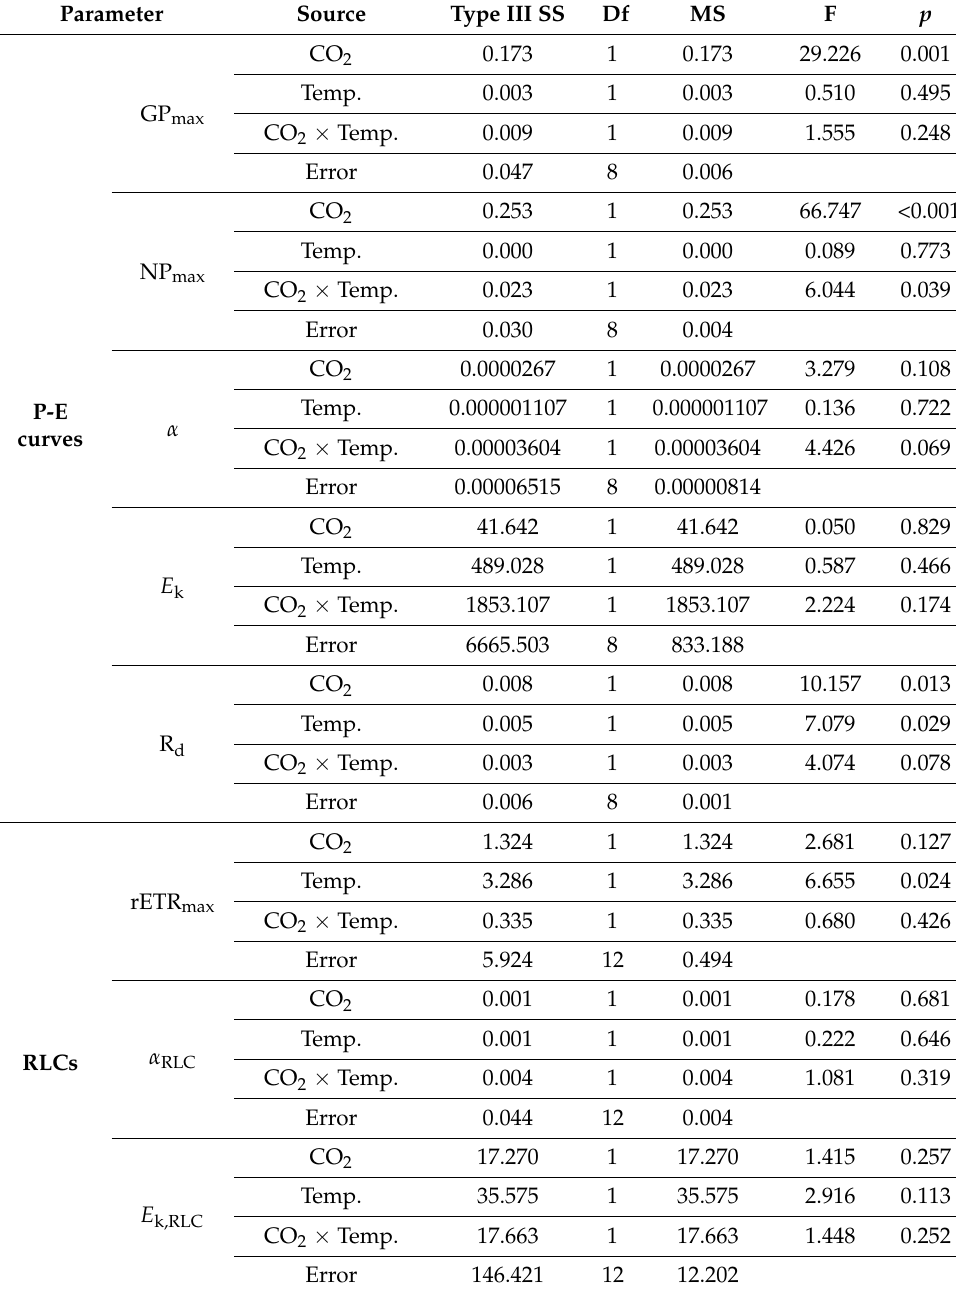
Table 3. Two-way ANOVAs to evaluate the individual and combined effects of CO 2 and temperature on photosynthetic parameters of Caulerpa sertularioides